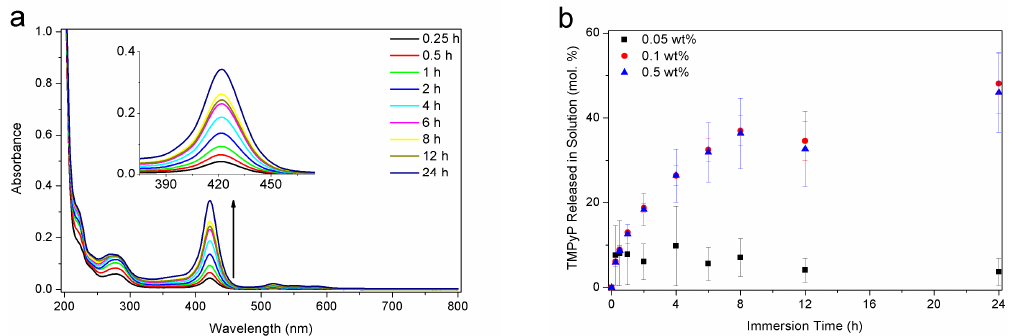
Figure 6. UV-Vis spectra of the phosphate buffered saline solution (PBS) solution various times after immersion of a TMPyP-loaded sample made with 0.5 wt % α -HAP ( a ) and plot of the molar percentages of TMPyP released into the PBS solution from dye-loaded samples made with the three different photoinitiator concentrations ( b ). The molar percentage of dye is calculated from the absorbed amount of dye in each hydrogel.